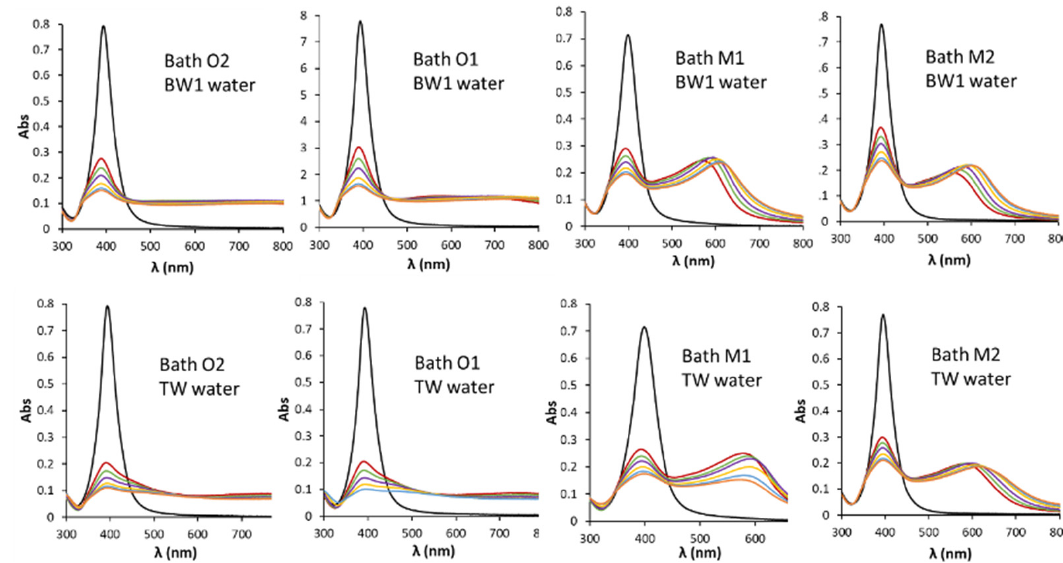
Figure 4. Spectra of the several batches diluted 1/4 with bottled mineral water 1 and tap water measured at several times (0.5, 1, 2, 5, 10, 15 min). The SPR band for the dilution with ultrapure water was also included.